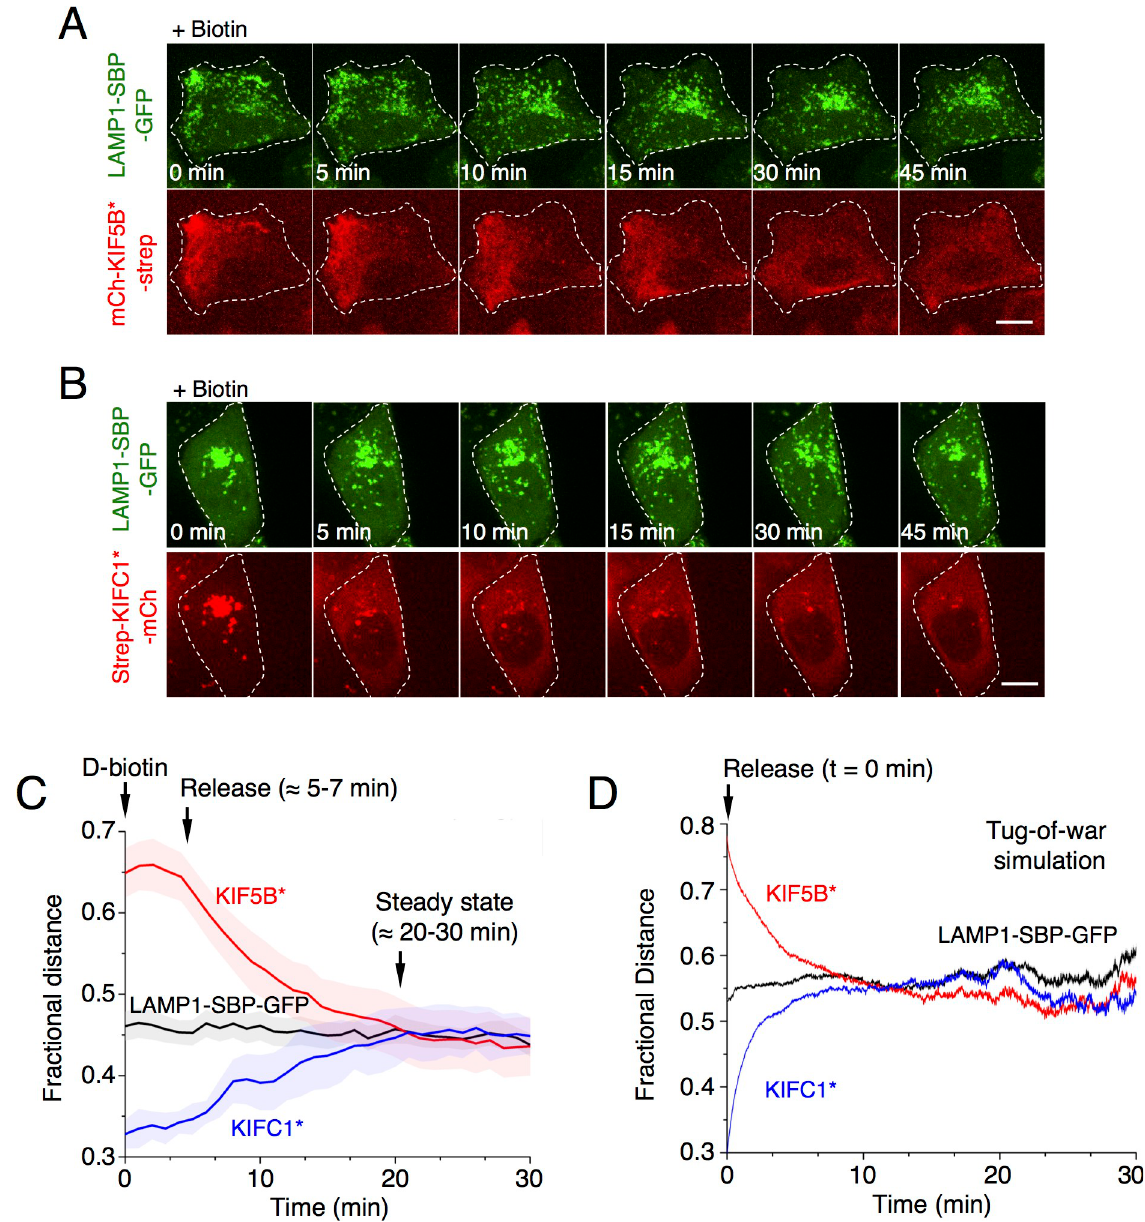
Fig 3. Analysis of the reversal of lysosome redistribution after addition of biotin. (A,B) HeLa cells were co-transfected with plasmids encoding (A) LAMP1-SBP-GFP and mCh-KIF5B � -strep (see S1 Movie) and (B) LAMP1-SBP-GFP and strep-KIFC1 � -mCh (see S2 Movie), resulting in the accumulation of lysosomes at the periphery or center of the cells, respectively. At 24 h after transfection, biotin was added, and the return of lysosomes to their normal distribution was recorded by live-cell imaging. Scale bars: 10 μ m. (C) Quantification of the reversal of lysosome redistribution from S1 and S2 Movies (average fractional distance ( f = 75%) of lysosomes as a function of time after biotin addition), in comparison to lysosomes expressing only LAMP-SBP-GFP (also check S4 Fig and Methods for details). Values are the mean ± SD from three independent experiments. (D) Results from simulations of a computational model based on a stochastic model of tug-of-war (S1 Text) show the exponential recovery, reaching normal distribution in a WT context of lysosomes undergoing tug-of-war with the endogenous KIF5B and KIF1B kinesins and dynein [28]. Values are the mean ± SEM from 500 independent cargo initial configurations for each condition. Summary data available as Supporting Information (S1_Data.xlsx). GFP, green fluorescent protein; KIF, kinesin superfamily; LAMP, lysosome-associated membrane protein; mCh, mCherry; SBP, streptavidin-binding protein; strep, streptavidin; WT, wild type.